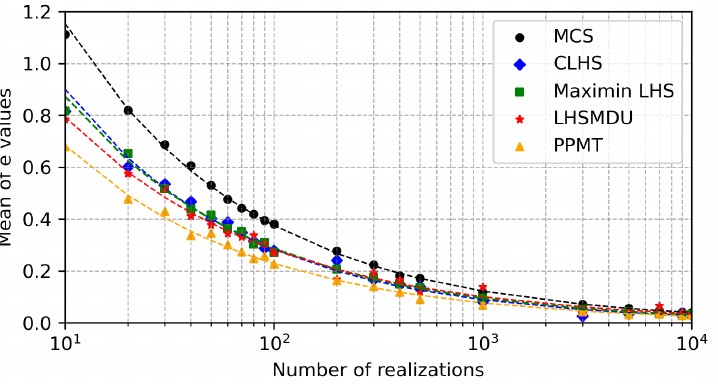
Figure 9. The averages of the e values versus the number of realizations generated by each sampling technique considering that the OOIP variables are uncorrelated.